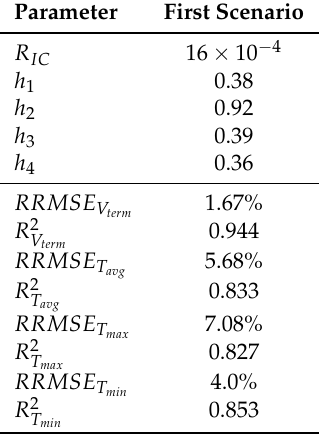
Table 11. Module-to-module discretization model calibration optimization results.